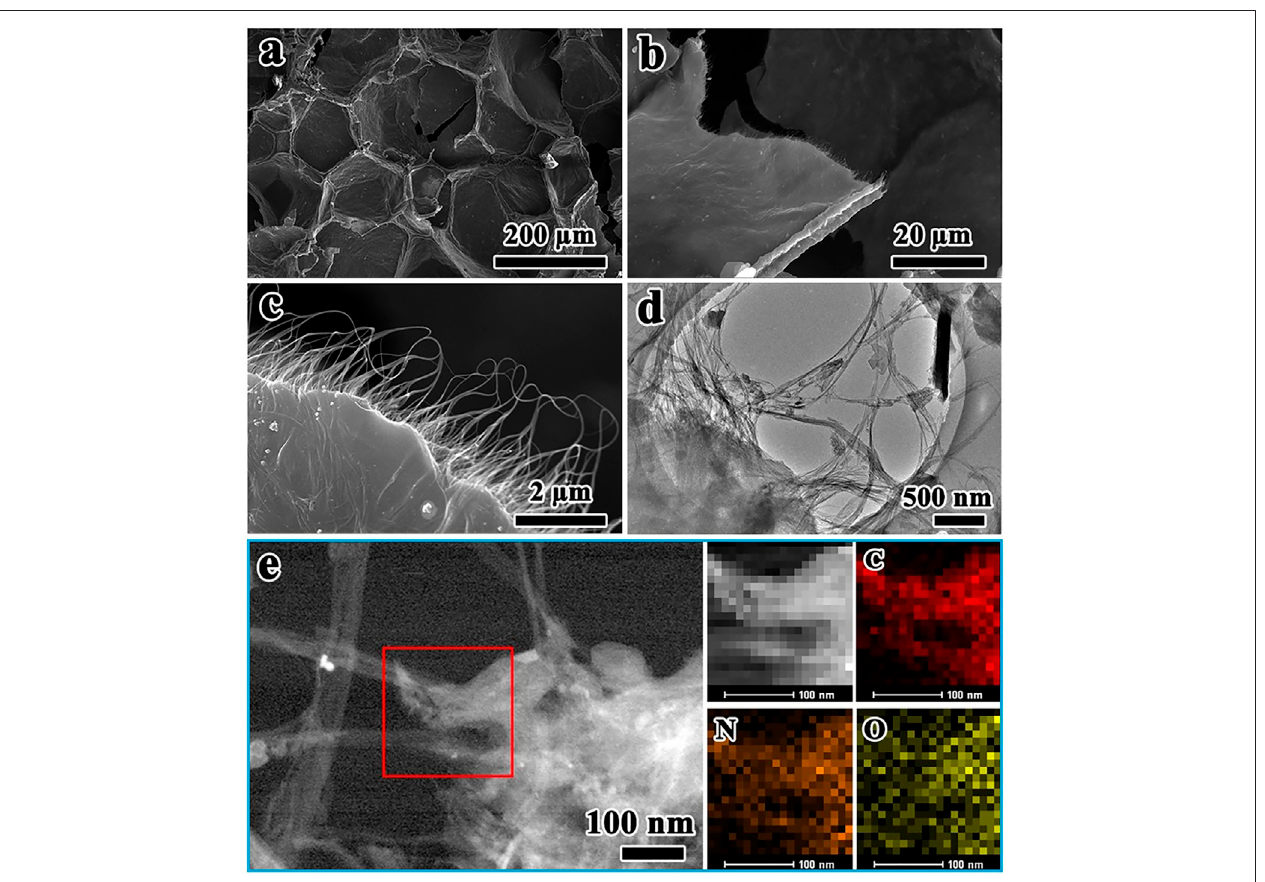
FIGURE 2 | (A – C) SEM images and (D) TEM image of NC@SWCNTs. (E) STEM image of NC@SWCNTs and the corresponding mapping images.